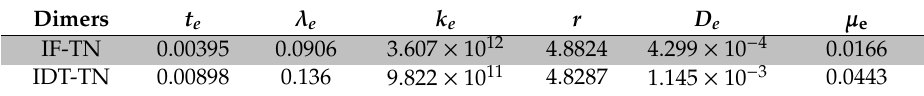
Table 5. Calculated electron transfer integral t e (eV), electron reorganization energy λ e (eV),